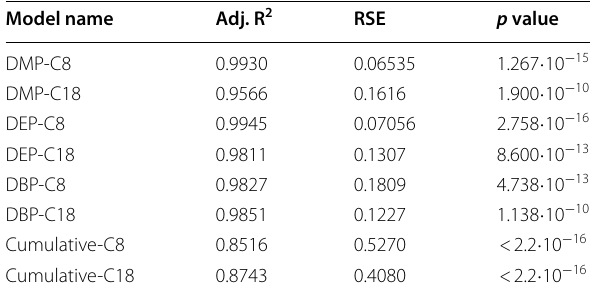
Table 1 Results of the statistical analysis of the theoretical model. p -values below 0.05 denote a statistical significance of the whole model